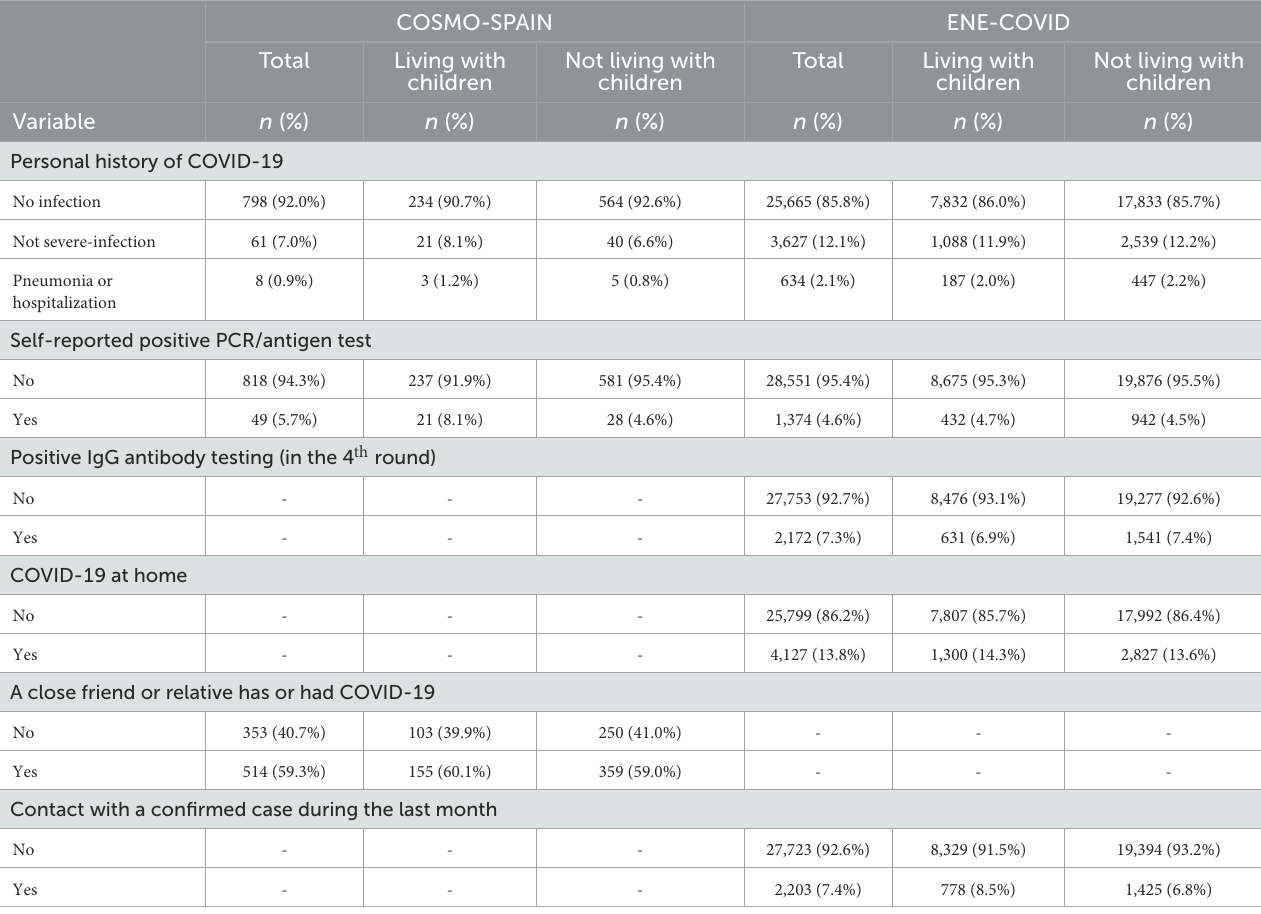
TABLE 2 COVID-19 history of COSMO-SPAIN and ENE-COVID participants aged 25–64 years, according to the presence of children in the household, November